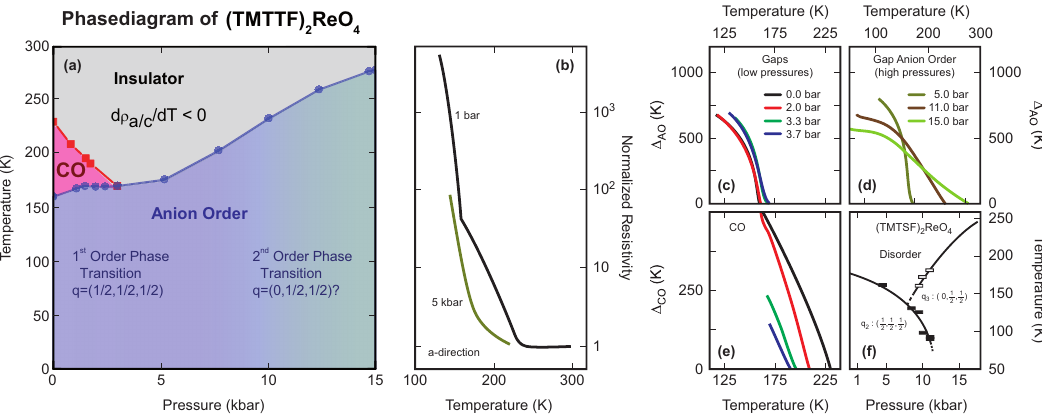
Figure 15. ( a ) Phase diagram of (TMTTF) 2 ReO 4 as obtained from our pressure- and temperature-dependent transport measurements. Even for 15 kbar hydrostatic pressure, no metallic behavior is observed up to room temperature. The charge-ordered phase is limited to low pressure values. The transition into the anion-ordered state changes from first to second order. ( b ) Normalized dc resistivity versus temperature measured at 1 bar and 5 kbar along the chain direction of (TMTTF) 2 ReO 4 ; reproduced from [41]. ( c – e ) Temperature change of the activation energy obtained below the AO transition and CO transition of (TMTTF) 2 ReO 4 for different pressure. ( f ) Temperature-dependent anion-ordering phase diagram of (TMTSF) 2 ReO 4 as obtained from X-ray scattering experiments of Moret et al. [62]. The q 2 and q 3 phase boundaries overlap at p = 9.5, 10, and 11 kbar and they have opposite